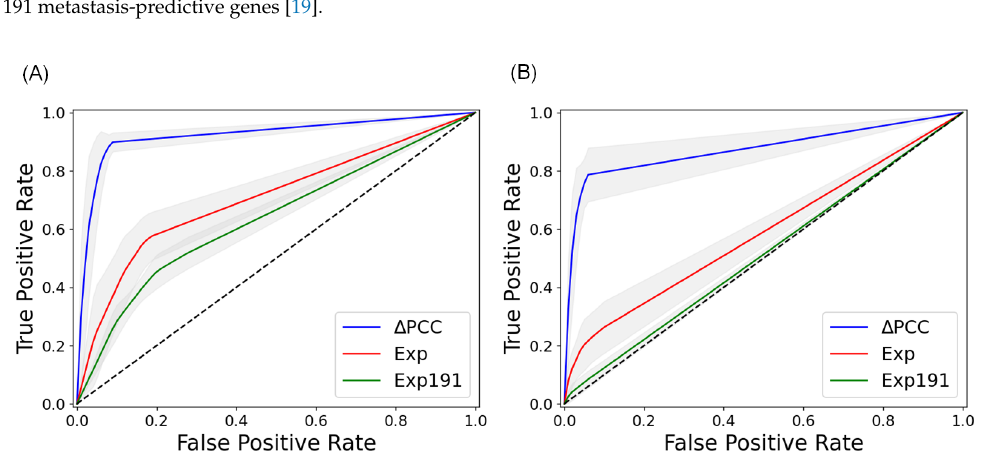
Figure 1. ROC curves of three types of features in predicting metastasis of COAD in independent testing. ( A ) Average ROC curves in predicting lymph node metastasis of COAD. ( B ) Average ROC curves in predicting distant metastasis of COAD. ∆ PCC: ∆ PCC of miRNA–RNA pairs, Exp: Expres- sions of genes involved in miRNA–RNA pairs, Exp191: Expressions of 191 metastasis-predictive genes [19]. The curves are the average ROC curves of 10 runs. The gray part indicates the error range of the ROC